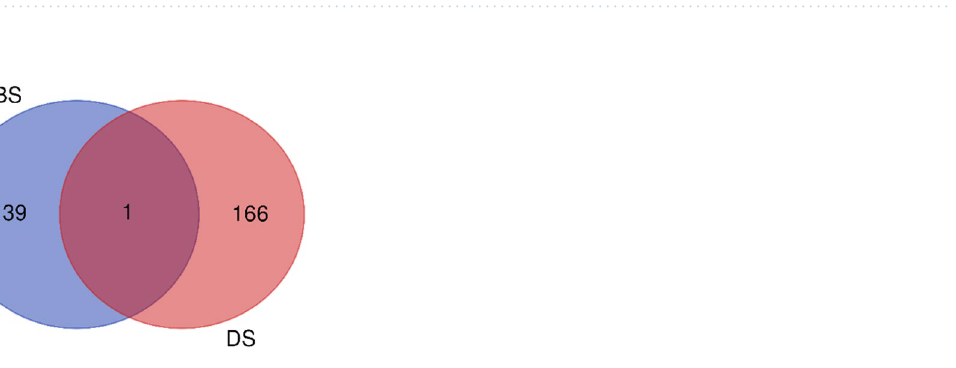
Table 1. Overview of sequencing, assembly and analysis.